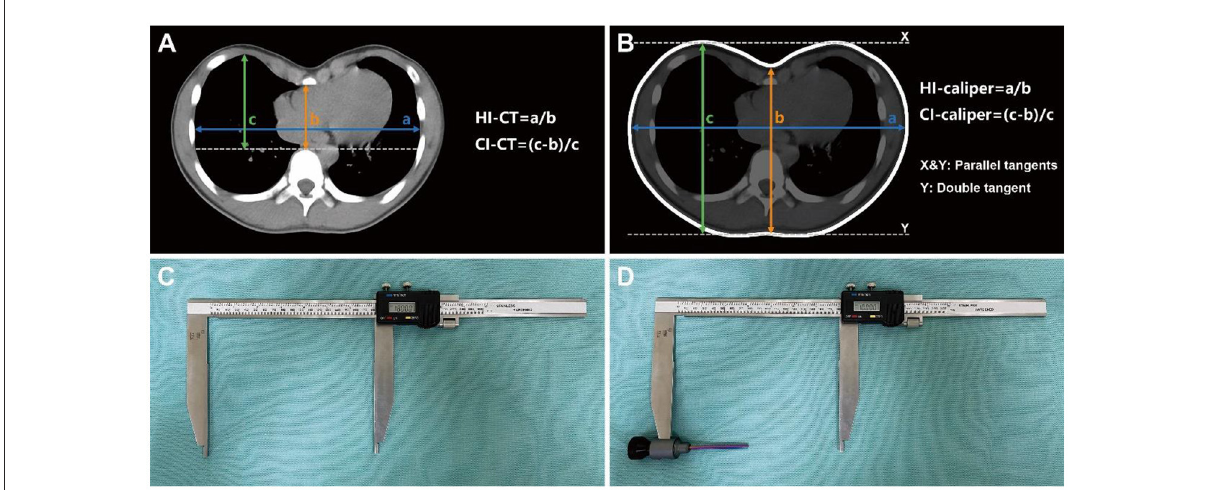
FIGURE1 Severity indices and measuring caliper. (A) CT-based severity indices of internal measurement, targeting the bony thorax from pleura to pleura. (B) Caliper-based severity indices of external measurement, targeting the body surface from skin to skin. (C) Caliper for measuring the maximum distance between the parallel tangents of bilateral chest wall (a in B ) and the maximum distance between the parallel tangents of anterior-posterior chest wall (c in B ). (D) Caliper with “probe” installed for measuring the minimum distance from the deepest point of anterior chest wall depression to the double tangent of bilateral posterior chest wall (b in B